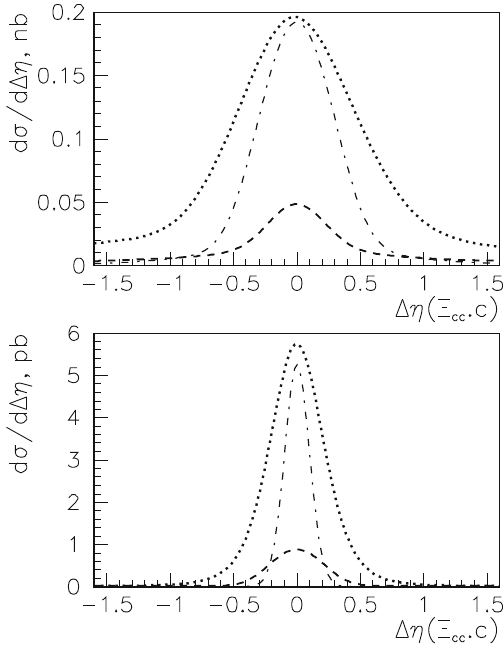
Fig. 3 The process g + g → Ξ cc + ¯ c + ¯ c ; pseudorapidity difference between the Ξ cc baryon and the comoving ¯ c -quark as seen under the different kinematic constraints. Upper panel: dotted, p Ξ T > 5 GeV, > 20 GeV; dashed, p Ξ > 20 GeV, p ∗ > 20 GeV; dash-dotted, p ∗ T T T > 50 GeV; m ∗ < E ∗ / 3. Lower panel: dotted, p Ξ T > 20 GeV, p ∗ T > 50 GeV; dash-dotted, m ∗ < E ∗ / dashed, p Ξ T > 50 GeV, p ∗ T